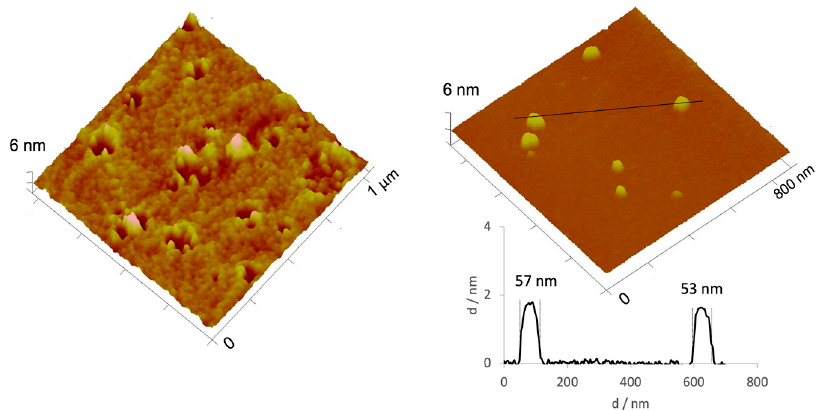
Figure 4. 3D atomic force microscopy (AFM) images of non-diluted ( left ) and diluted ( right ) AgNPs recovered by solvent evaporation. A profile was added for the diluted sample.